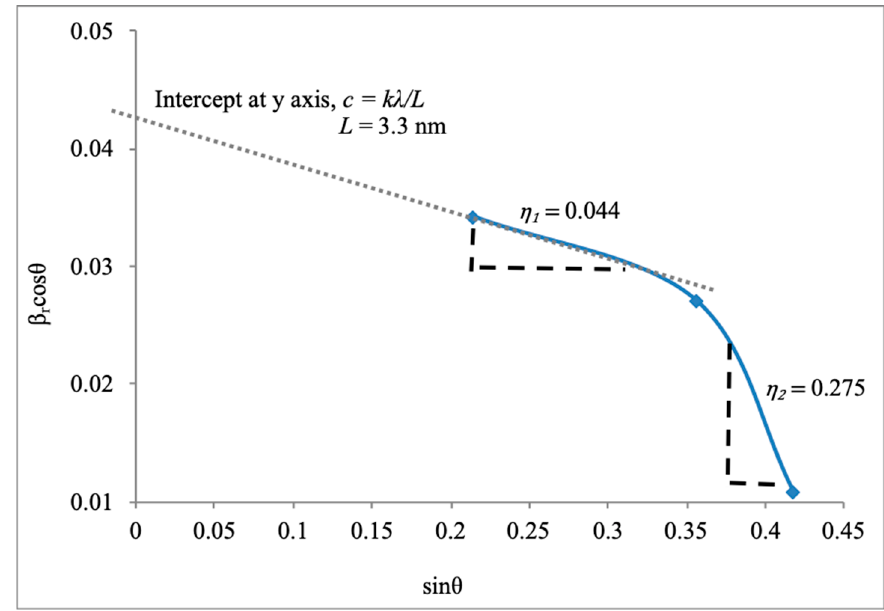
Processes 2018 , 6 , x FOR PEER REVIEW Figure 6. Plot of β r cos θ versus sin θ from XRD data of the 0.5 min sample. Figure 6. Plot of β r cos θ versus sin θ from XRD data of the 0.5 min sample.